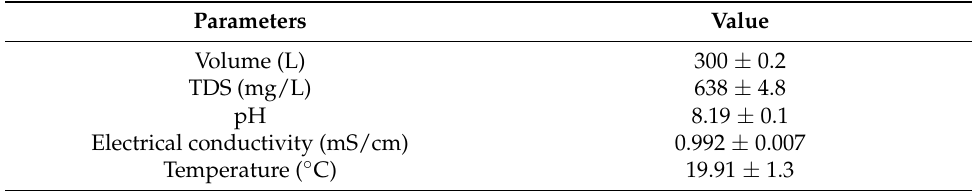
Table 3. Characteristics of well water.